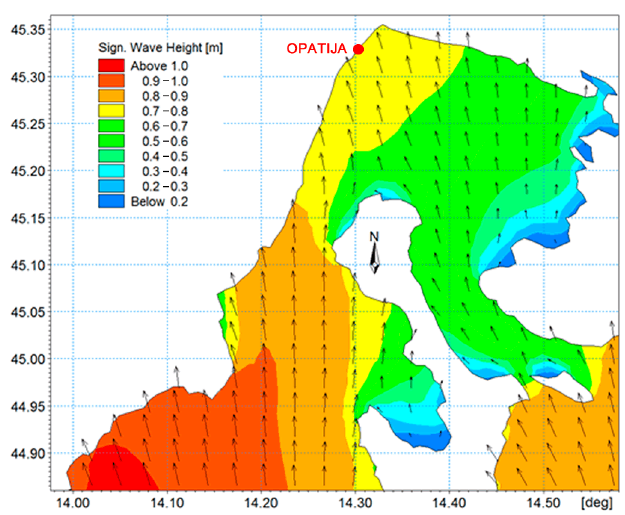
Figure 20. Field of significant wave heights for the situation of strong Sirocco wind (4 March 2017).